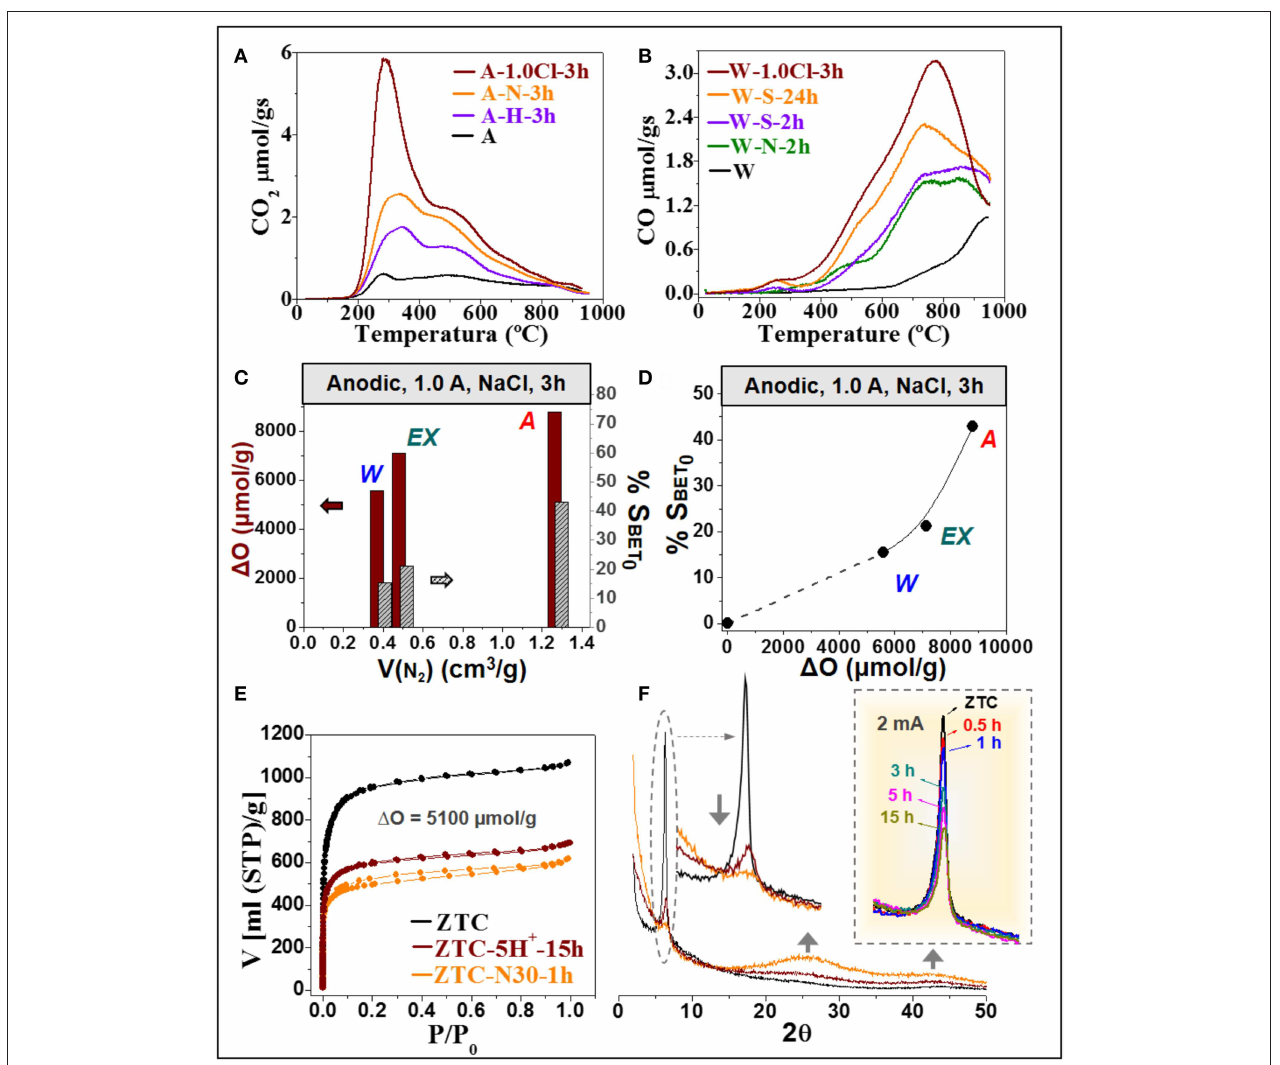
FIGURE 5 | (A,B) Comparison of CO 2 -like (for A sample) (A) , and CO-like (for W sample) (B) TPD profiles of samples oxidized under different chemical or electrochemical conditions; (C,D) Influence of the micropore volume of the studied ACs (V(N 2 )) in the SOGs gain ( 1 O) and S BET decrease (%SBET 0 ) (C) , and relation between this SOGs gain and S BET decrease (D) for a given anodic oxidation treatment (1.0A, in NaCl, 3h); (E,F) Comparison of N 2 adsorption-desorption isotherms ( − 196 ◦ C) (E) , and X-ray diffractograms (F) of the ZTC before and after chemical and electrochemical oxidation treatments with similar efficiency ( 1 O = 5100 µ molO/g). Inlet of (F) example of the high control on the structural degradation (111-X-ray characteristic peak of the ZTC ) achieved by electrochemical oxidation in NaCl at low current